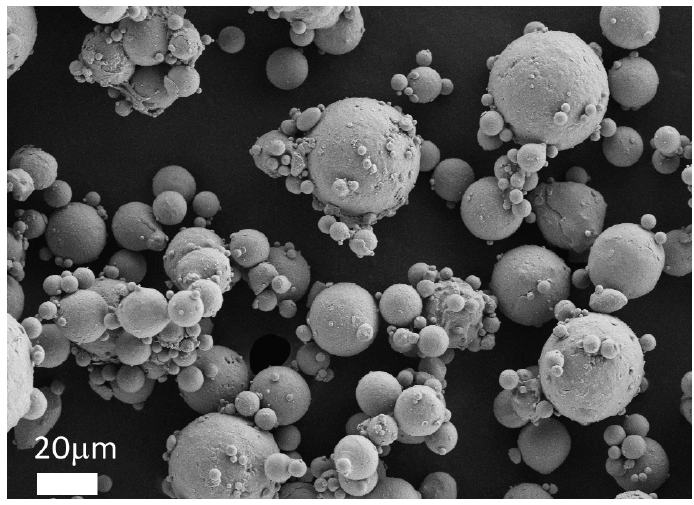
Figure 2. Field Emission Scanning Electron Microscopy (FESEM) image of gas atomized aluminum powders: the particles are spherical and their size varies between 1 and 30 μ m.